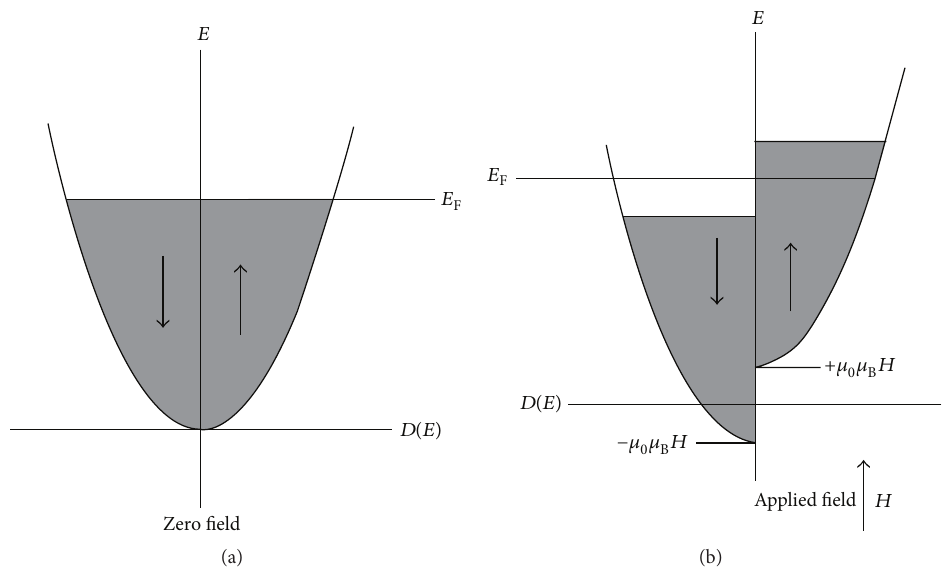
Figure 4: The schematic explanation of Fermi energy model of magnetic properties of materials. In (a) position, the up/down spins are located in balance states before applying external field. In (b) position, by applying external field, the energy state of aligned spins is higher than other ones; so, the magnetic properties are created [60].